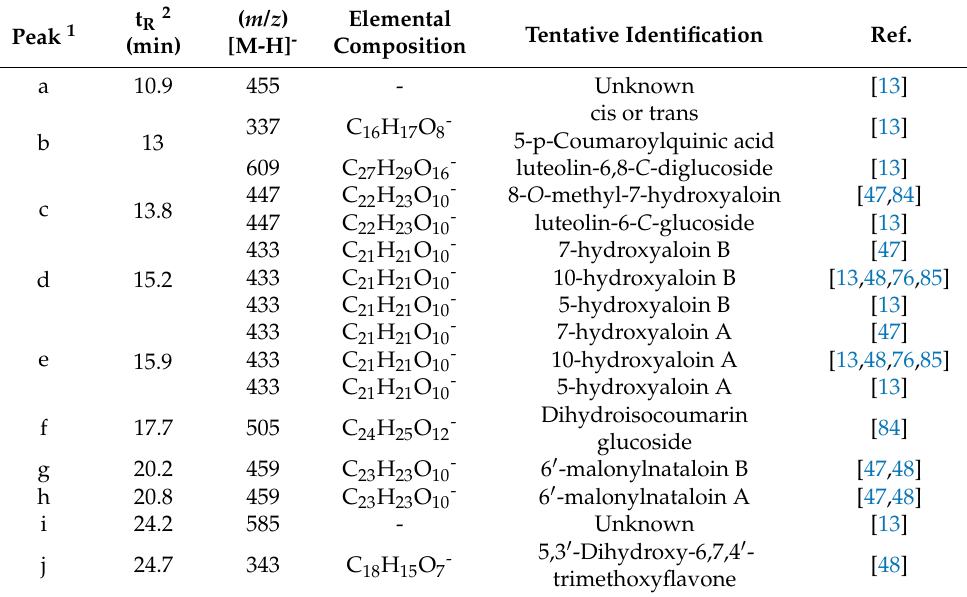
Table 6. Tentative identification of unknown phenolic compounds in AVE by HPLC-MS. Peak 1